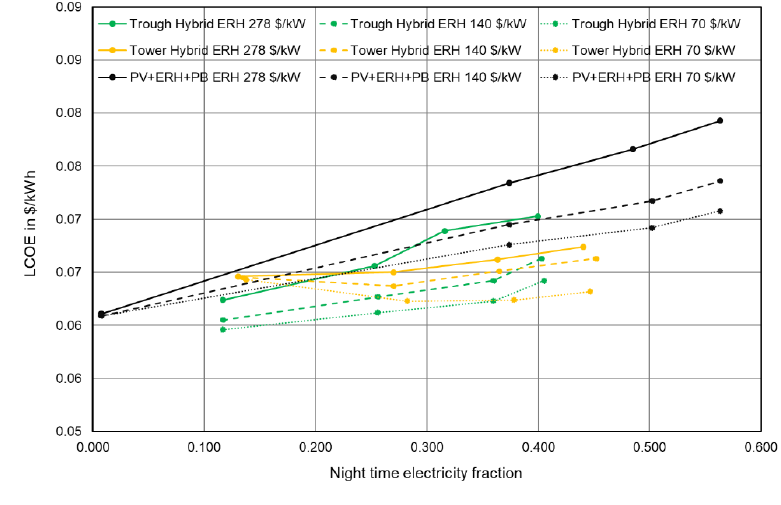
Figure 10. Variation in the ERH costs at Riyadh.